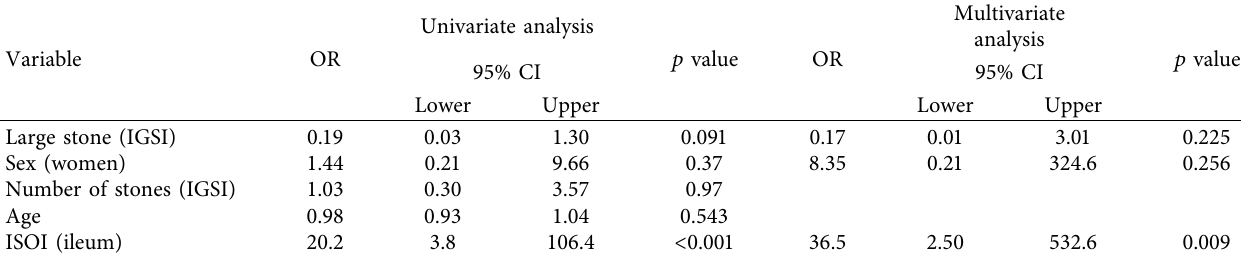
Table 3: Logistic regression analysis of the factors affecting the risk of RSOI